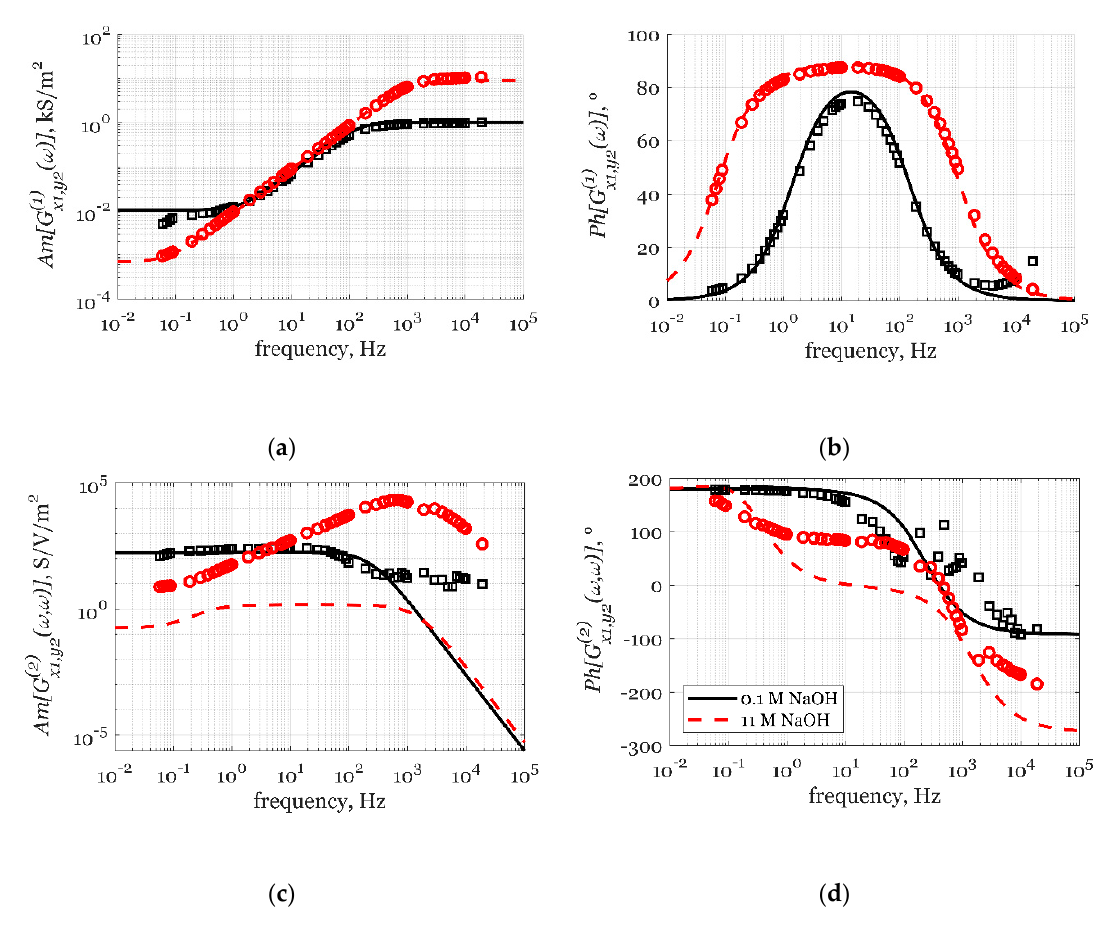
Figure 15. Comparison of the theoretical, cNFR derived (lines), and experimental obtained (symbols) dimensional FRFs: ( a ) amplitude of the first-order FRF; ( b ) phase of the first-order FRF; ( c ) amplitude of the symmetrical second-order FRF and ( d ) phase, of the symmetrical second-order FRF relating the current density as the output, and electrode potential as the modulated input for two different NaOH concentrations: 0.1 M and 11 M NaOH (black and red, respectively).